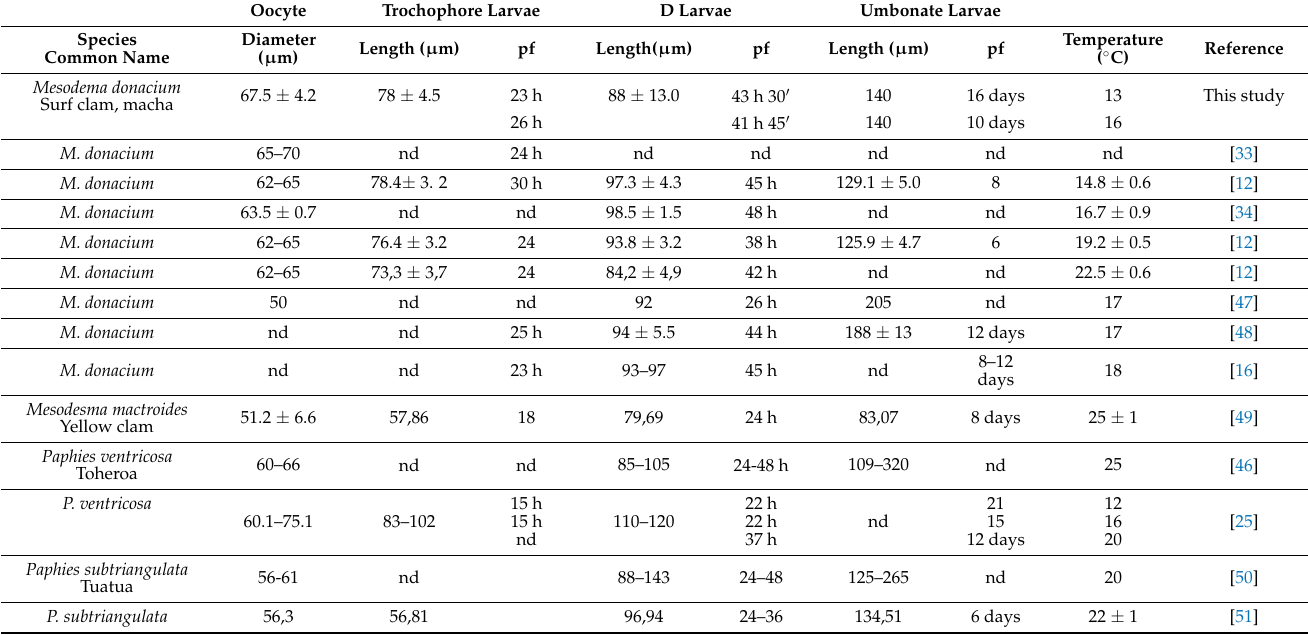
Table 2. Comparison of the size values of oocytes and larvae during the development of the surf clam Mesodesma donacium obtained in the present study with respect to results obtained with the same species and other species of the family